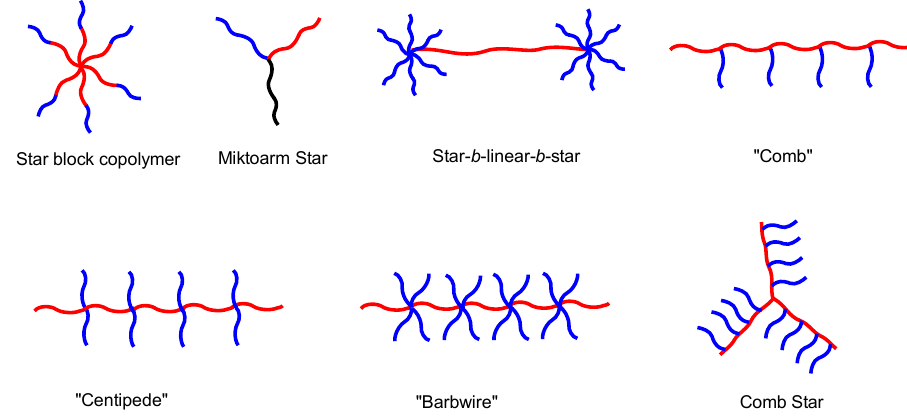
Figure 3. Illustration of complex architectures using living anionic polymerization and coupling chemistry. Adapted from Reference [55]. (Copyright (2017) WILEY-VCH Verlag GmbH & Co. KGaA,